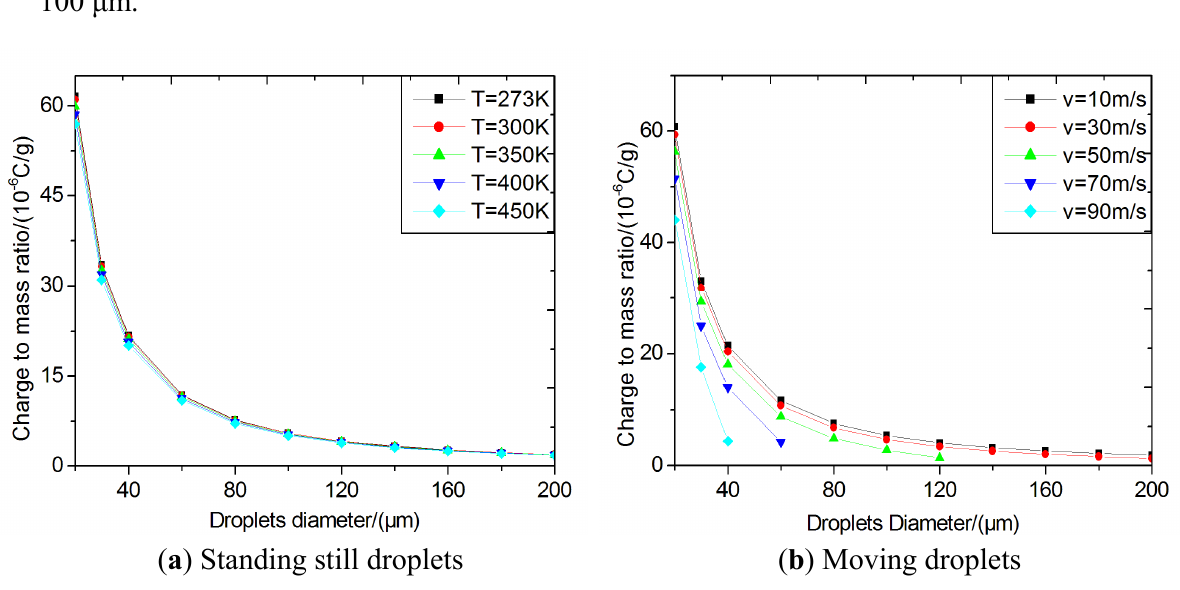
Figure 4. Critical specific charges using the stability criteria for bag break-up